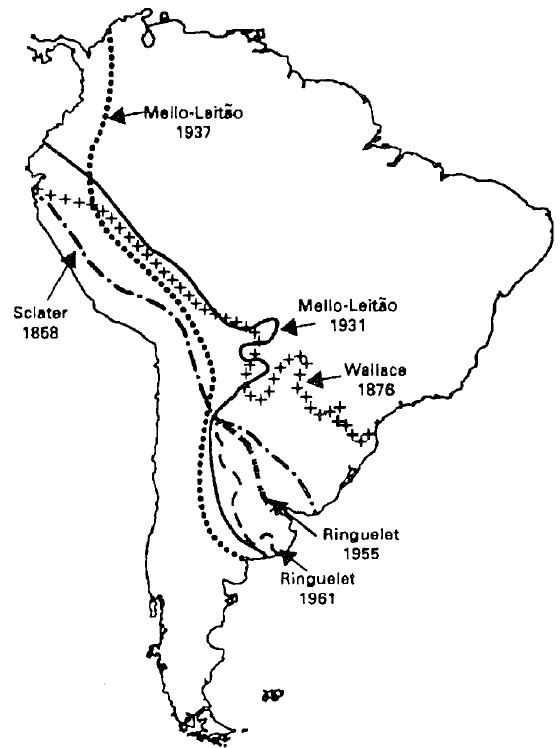
Fig. 7. Limits between Guianan-Brazilian and Andean-Patagonic sub-regions according to several authors (from Morrone